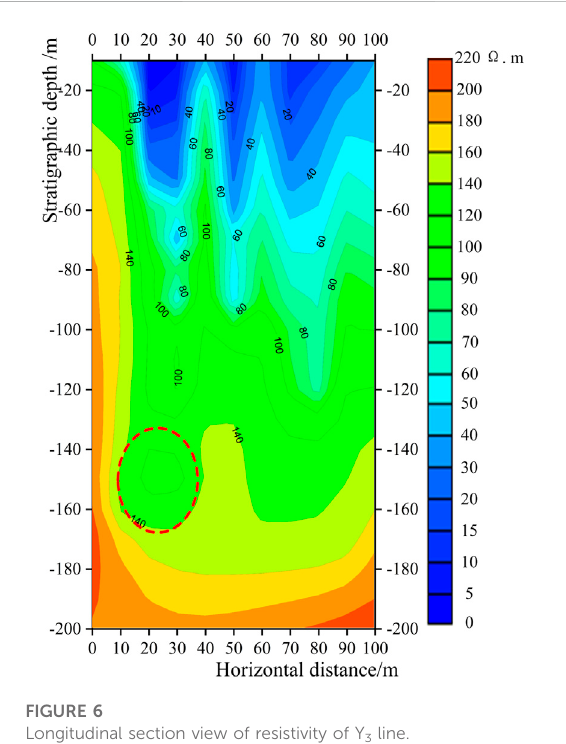
FIGURE 6 Longitudinal section view of resistivity of Y 3